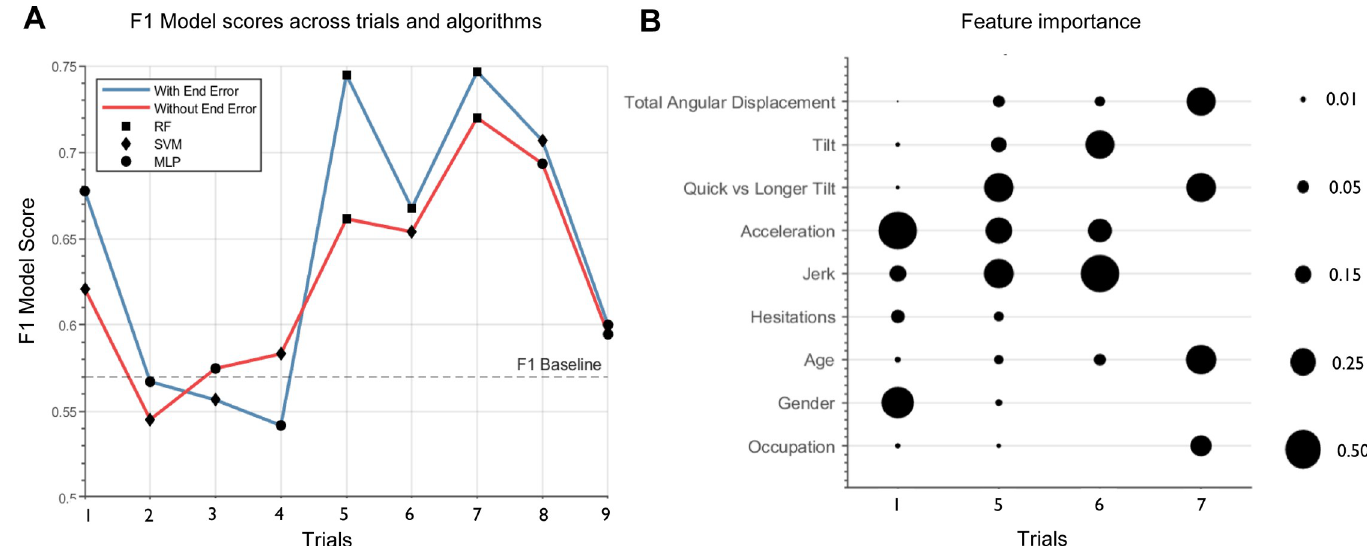
Fig 2. Machine learning models and feature importance. A F1 scores for the best performing algorithm are shown. A random predictor would score 0.57, with a score of above 0.57 representing better-than-chance APOE status classification performance. Blue line includes all features. Red line excludes the path integration feature, end error. B Importance scores are represented by the circle diameter and were derived for the best performing model on each of the trials shown. Scores vary between 0 and 1 depending on the proportion of influence the feature has for that trial. RF = Random Forest, SVM = Support Vector Machine, MLP = Multi-Layer